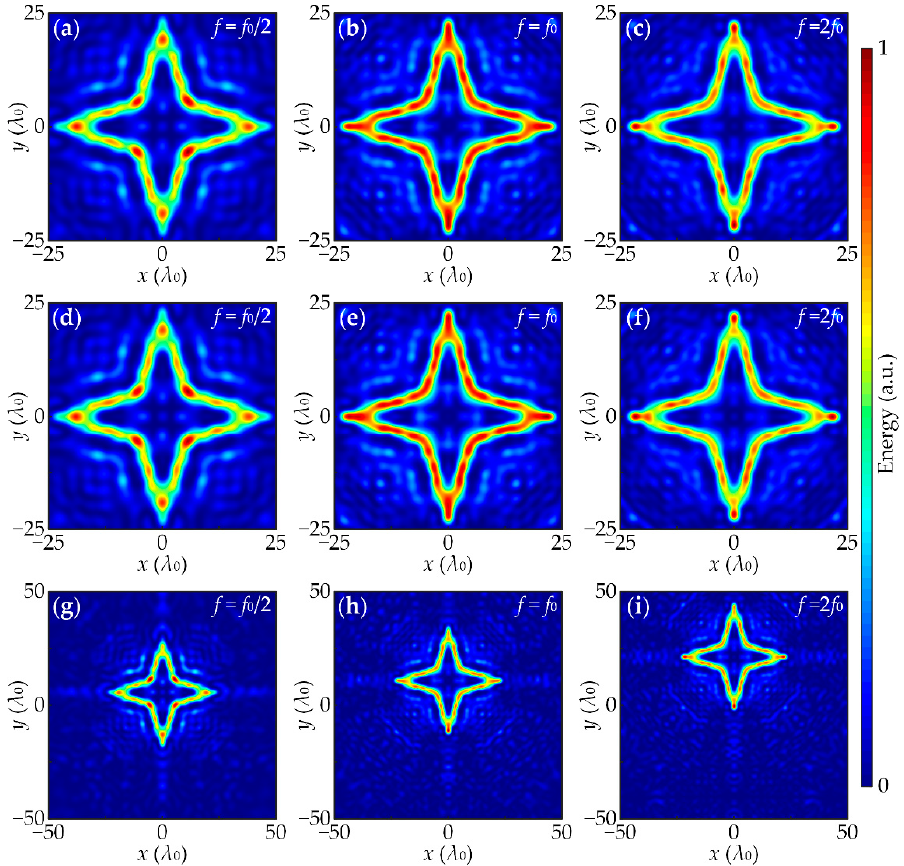
Figure 7. Holographic images of the cases that may cause errors. ( a – c ) The normalized sound energy distributions in the image planes of the ASM-based hologram with a small displacement of holes from their ideal places are calculated using numerical simulation when the incident frequencies are f 0 /2, f 0 , and 2 f 0 , respectively. ( d – f ) The normalized sound energy distributions in the image planes of the ASM-based hologram with a dispersion of hole size are calculated using numerical simulation when the incident frequencies are f 0 /2, f 0 , and 2 f 0 , respectively. ( g – i ) The normalized sound energy distributions in the image planes of the ASM-based hologram for incidence wave with a 5 ◦ declination are calculated using numerical simulation when the incident frequencies are f 0 /2, f 0 , and 2 f 0 , respectively. Since the incident direction of the plane sound wave is inclined, the position of the image is shifted by z tan5 ◦ .